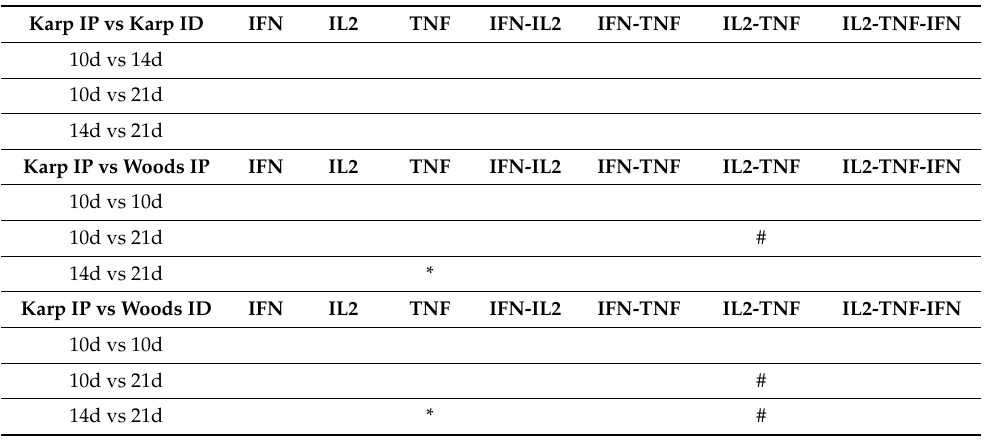
Table 4. Summary of the CD8+ T-cell population lethal and nonlethal (protective) cytokine signatures. Comparisons between lethal (Karp IP) and nonlethal (Karp ID, Woods IP, Woods ID) challenge models were performed in an intra- and interstrain fashion. Lethal signatures are designated by an asterisk (*) and nonlethal (protective signatures) are indicated by a hashtag (#), each indicating a significant increase ( p < 0.05) in the associated population of cytokine-producing cells. Karp IP vs Karp ID IFN IL2 TNF IFN-IL2 IFN-TNF IL2-TNF IL2-TNF-IFN 10d vs 14d 10d vs 21d 14d vs 21d